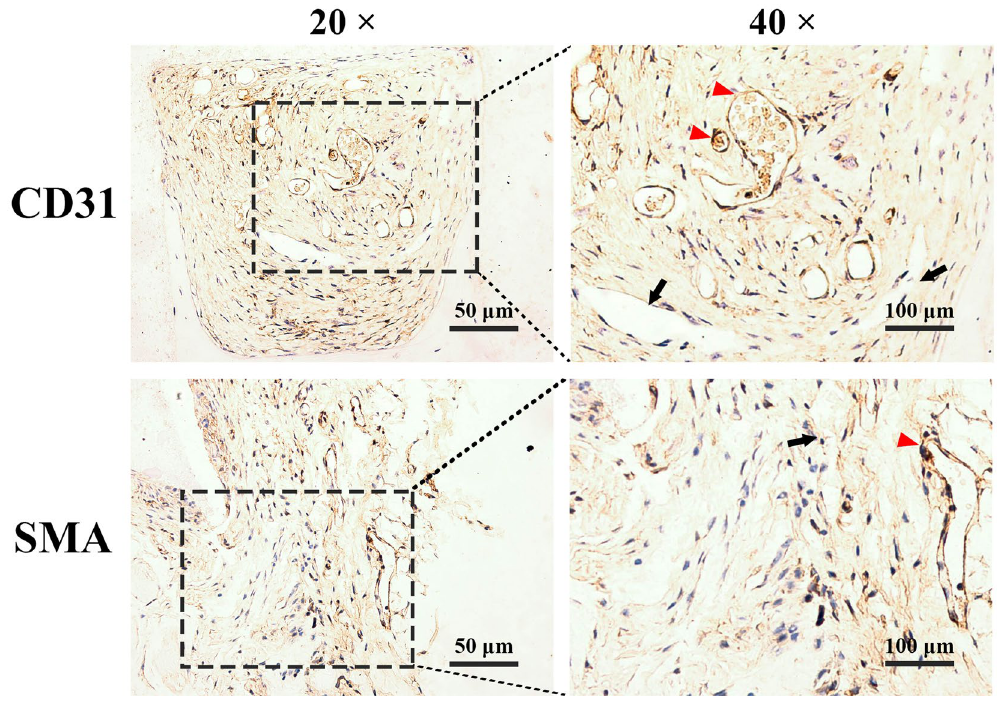
Figure 9. Representative immunohistological sections of 5%CS/ β -TCP scaffolds pre-seeded with HUVECs and hBMSCs and implanted into nude mice. A few luminal structures contained human CD31 and human SMC (red arrows), but others did not (black arrows) and were solely